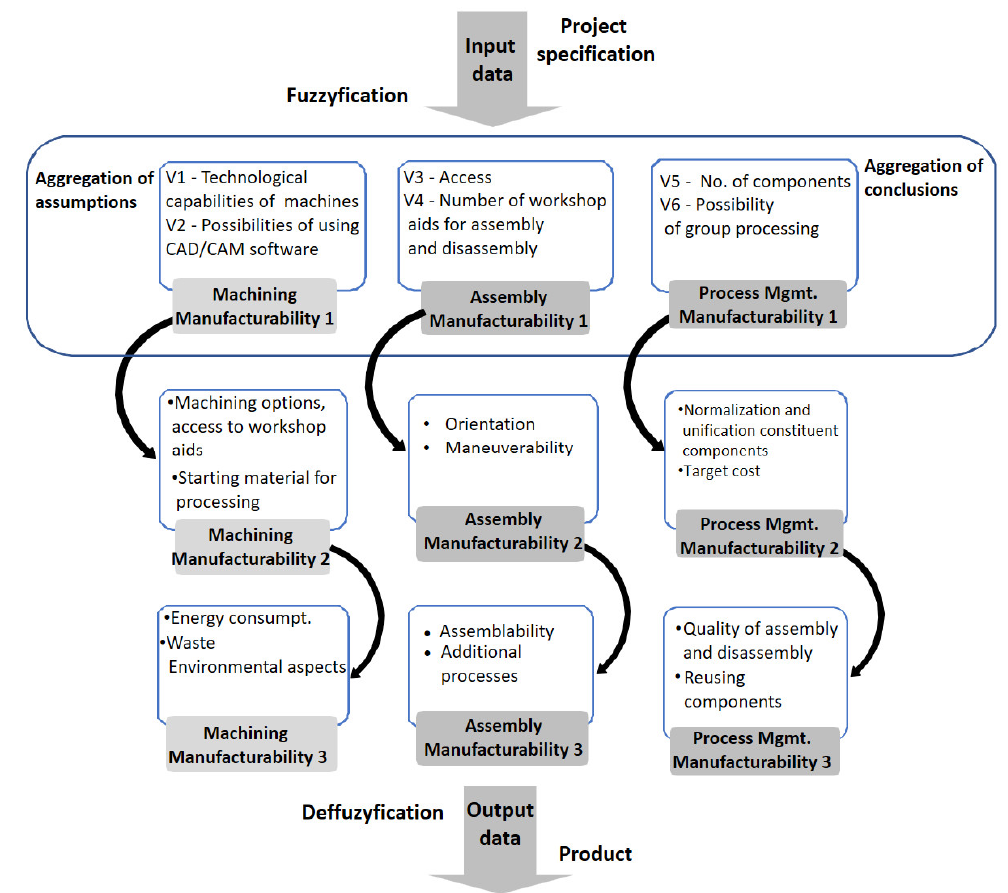
Figure 7. Model of the new method design for manufacturability based on three successive stages and substages of fuzzy inference (without feedback).